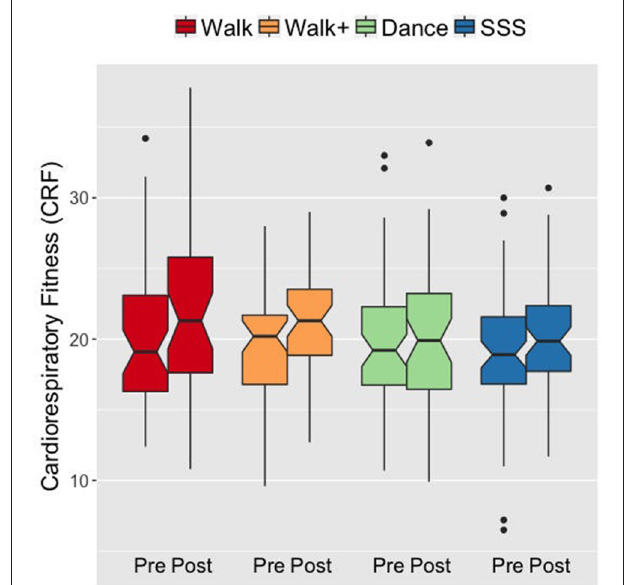
FIGURE 1 | Notched box plots show the distribution of CRF values before and after the intervention. The horizontal line marks the median. The notches extend to ± 1.58 IQR/sqrt(n). The upper and lower hinges correspond to the first and third quartiles. The whiskers extend from the hinge to ± 1.5*IQR of the hinge. IQR, inter-quartile range.